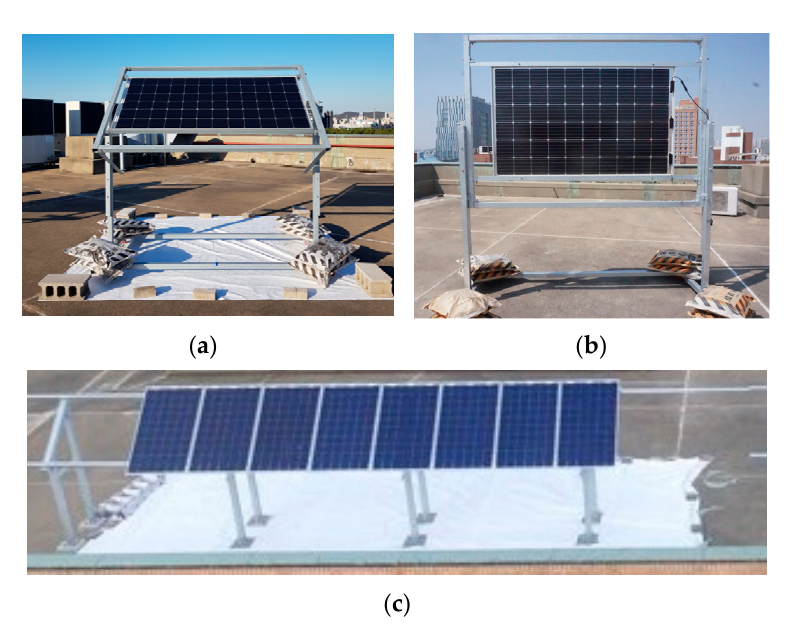
Table 4. Experiment categories.